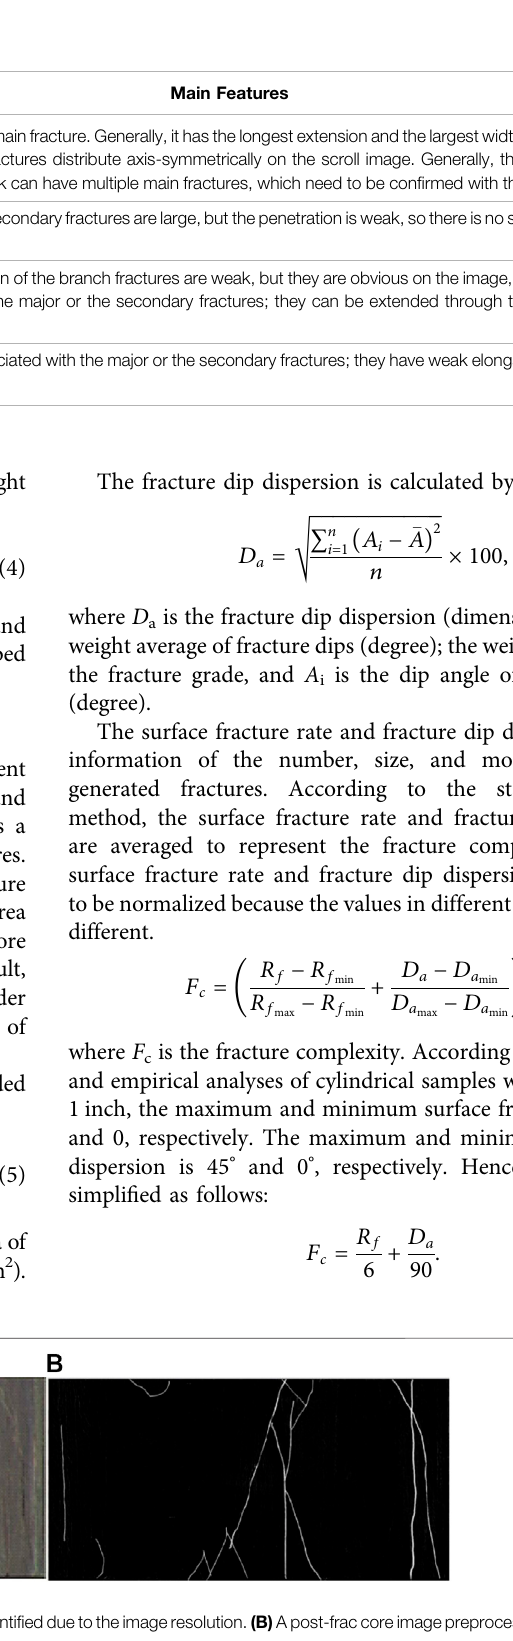
Frontiers in Earth Science |